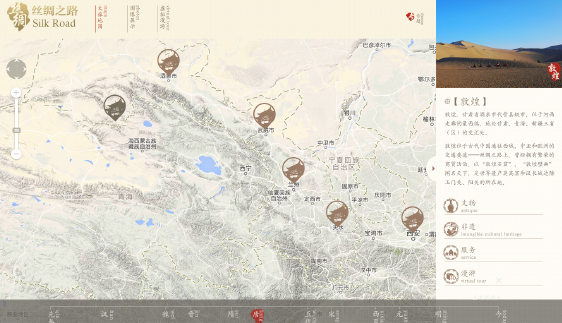
Figure 4: Example on interface design for the Time and space maps with right sidebar